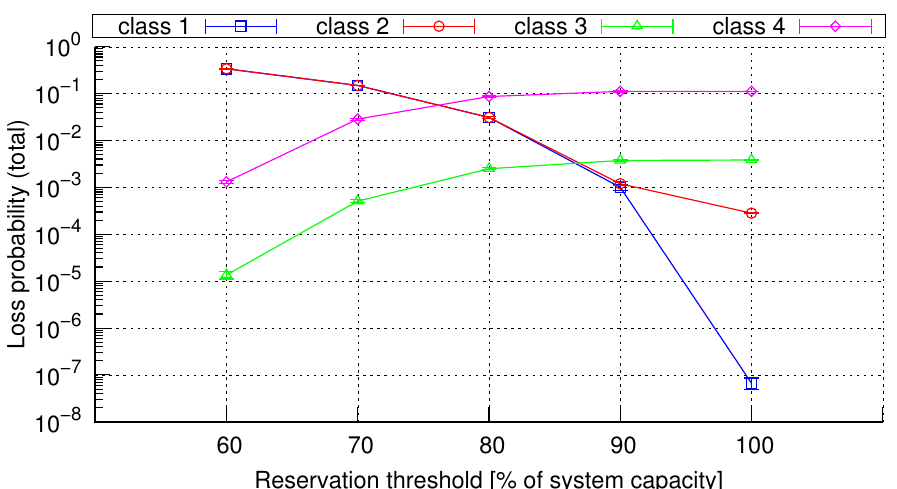
Figure 17. Changes in the loss probability for calls of individual traffic classes in System 2 in relation to the value of reservation threshold. The results are presented for the value a = 0.7 Erl of traffic offered to a single FSU.